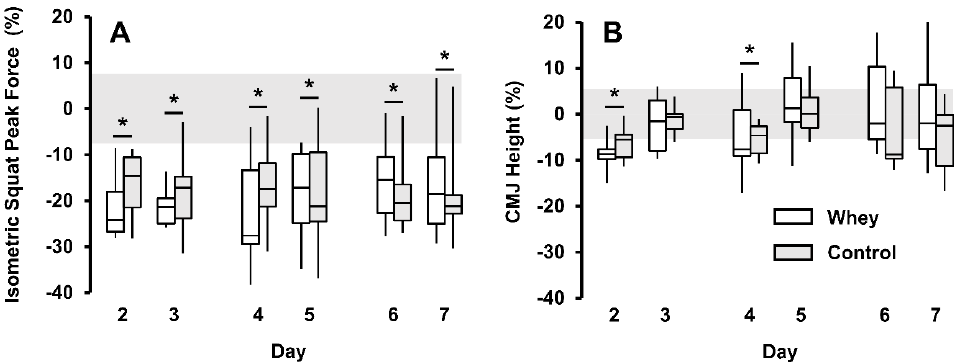
Figure 3. Isometric squat peak force % change (A) . Countermovement jump (CMJ) height % change (B) . Boxplot data are median (horizontal line), interquartile range (box), minimum and maximum (whiskers). Grey band represents measurement uncertainty (7.6% (A) and 5.4% (B) ). *Different from baseline ( p < 0.05). There was no difference between whey (white) and control (grey) groups for either measure ( p > 0.441).